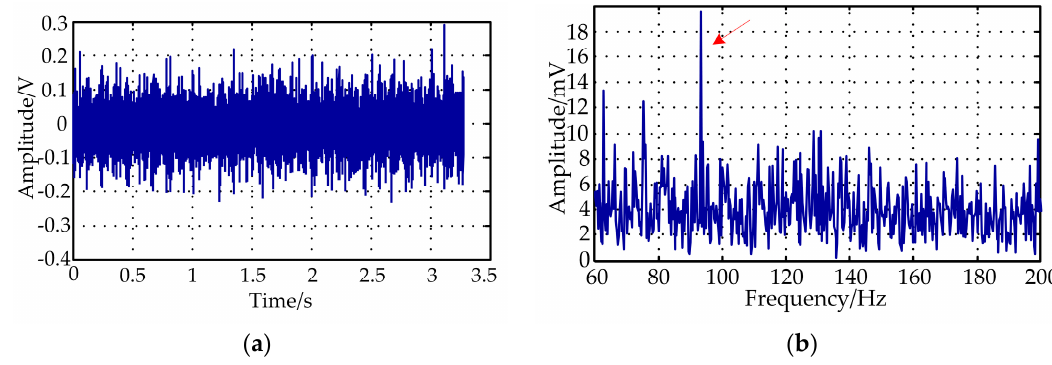
Figure 10. The waveform of the inner ring fault bearing vibration signal. ( a ) Time domain waveform; ( b ) envelope spectrum waveform.